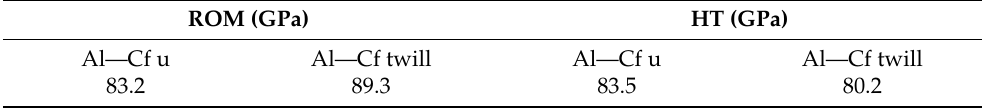
Table 3. Results of the mechanical